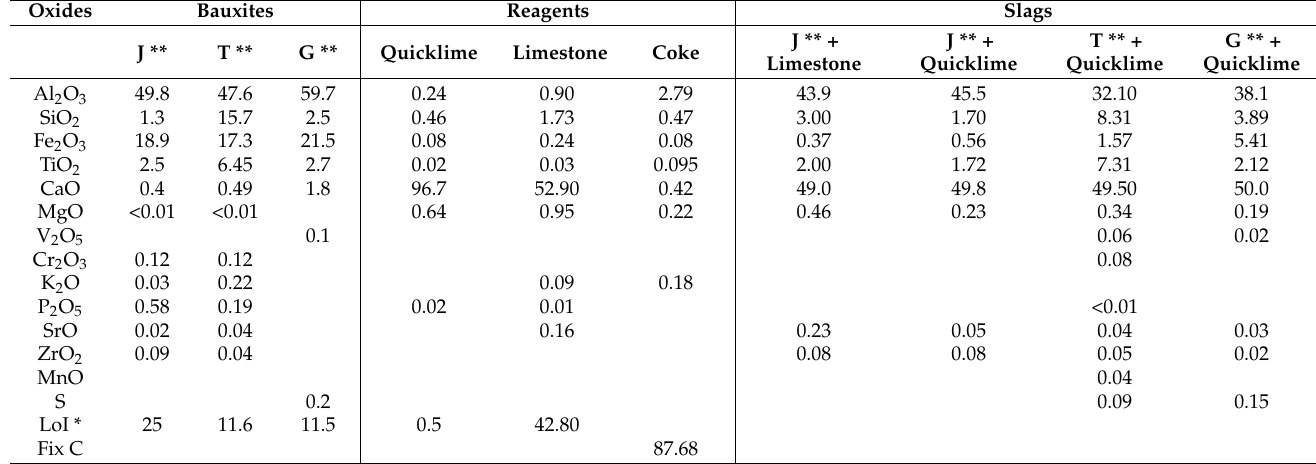
Table 1. Composition of the raw materials, measured by XRF,